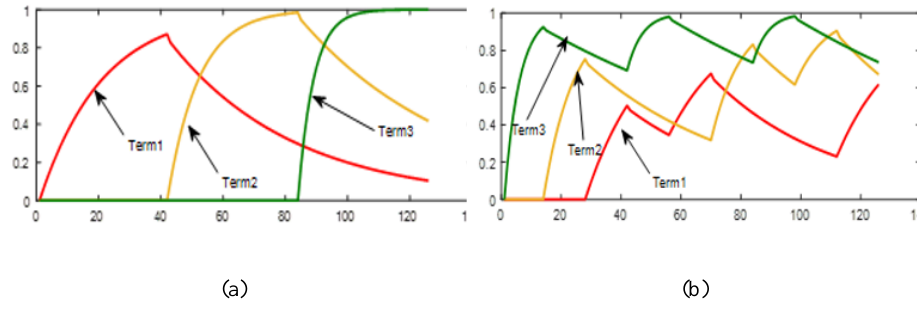
Fig. 9 Learning-forgetting functions for different sequence of reading